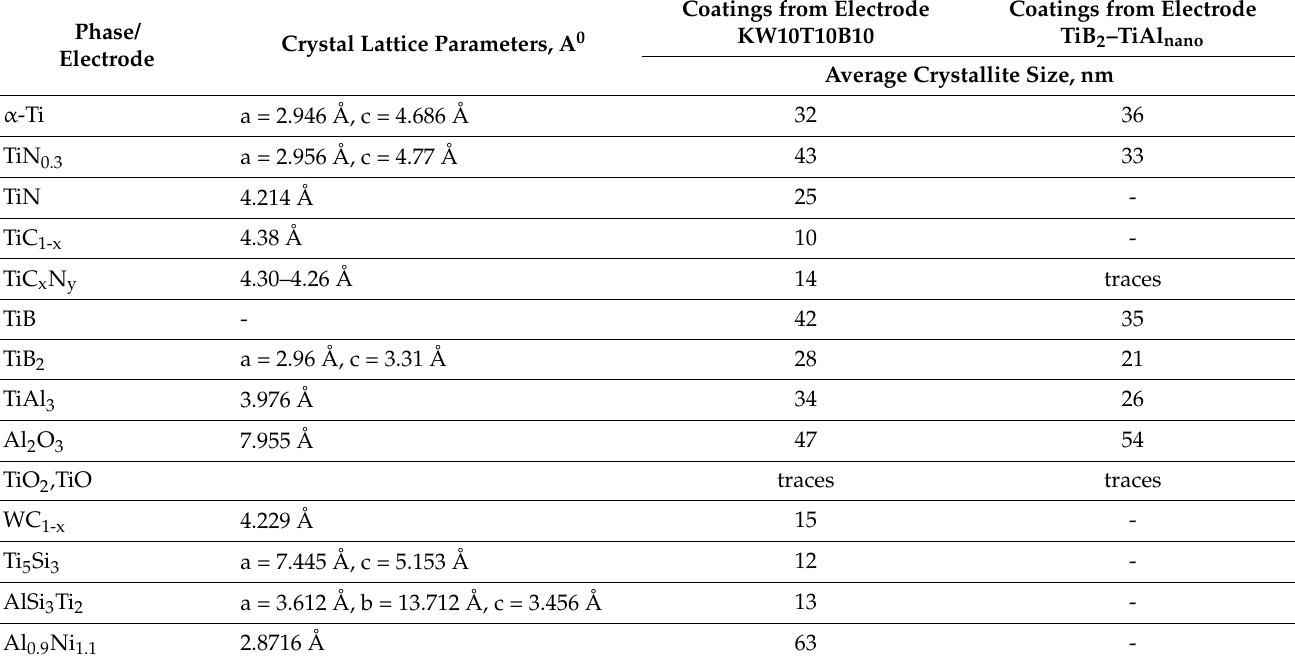
Table 2. Crystallite sizes of the main phases in the ESD coatings at pulse energy 0.03